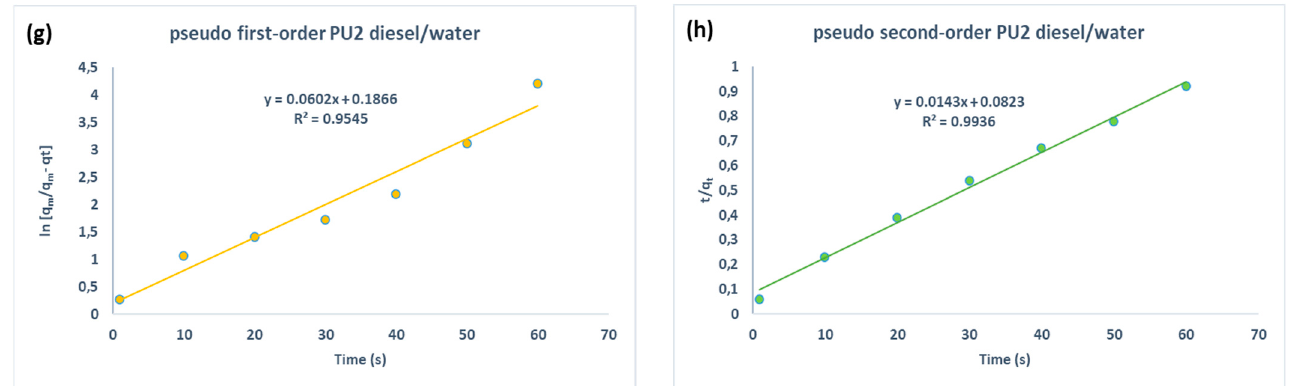
Figure 4. Pseudo first-order ( a ) and pseudo second-order ( b ) sorption linear fitting of PU1 in Figure 4. Pseudo fi rst-order ( a ) and pseudo second-order ( b ) sorption linear fi tt ing of PU1 in gaso- gasoline/water system. Pseudo first order ( c ) and pseudo second-order ( d ) sorption linear fitting line/water system. Pseudo fi rst order ( c ) and pseudo second-order ( d ) sorption linear fi tt ing of PU2 in gasoline/water system. Pseudo fi rst-order ( e ) and pseudo second-order ( f ) fi tt ing of PU1 in die- of PU2 in gasoline/water system. Pseudo first-order ( e ) and pseudo second-order ( f ) fitting of sel/water system. Pseudo fi rst order ( g ) and pseudo second-order ( h ) fi tt ing of PU2 in diesel/water PU1 in diesel/water system. Pseudo first order ( g ) and pseudo second-order ( h ) fitting of PU2 in system. diesel/water